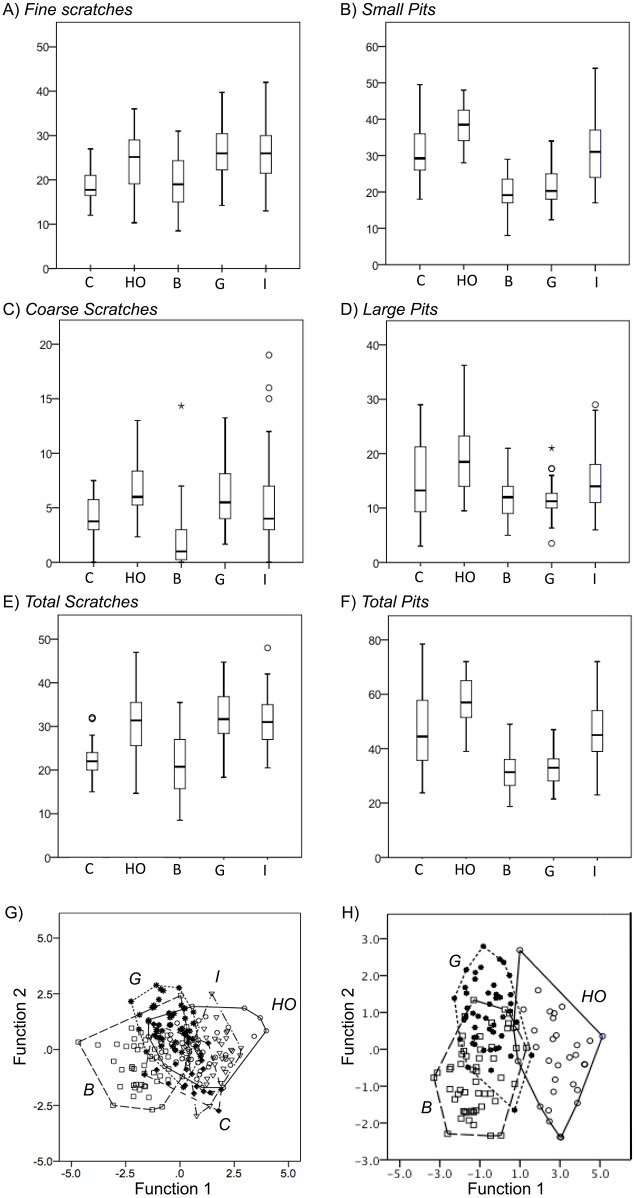
The relative frequencies of microwear variables within feeding guilds.A) Fine scratches (Sf), B) Small Pits (Ps), C) Coarse Scratches (Sc) D) Large pits (Pl), E) Total scratches, F) Total pits. Box plots show the median (center line), interquartile range (boxes), 1.5 times the interquartile range (whiskers), and outlier points. Discriminant analysis using the four independent variables (Sf, Sc, Ps, Pl) as dependents is depicted: G) all five feeding guilds included. Functions 1 and 2 are plotted and account for 71.8% and 24.6% of the variance, respectively. Wilks’ Lambda = 0.252, Chi-Square = 250.51, p<0.001. The discriminant function coefficients are Sf
0.039/0.578, Sc
0.499/0.688, Ps
0.845/−0.416, Pl
0.071/−0.166. F) Herbivores groups only (grazers, browsers, hard-object feeders). Functions 1 and 2 are plotted and account for 75.1% and 24.9% of the variance, respectively; Wilks’ Lambda = 0.194, Chi-Square = 192.80, p<0.001. The discriminant function coefficients are Sf
0.005/0.379, Sc
0.324/0.844, Ps
0.822/−0.330, Pl
0.270/−0.276. HO = Hard-Object Feeders, B = Browsers, G = Grazers, I = Insectivores, C = Carnivores. Hulls surround each dietary group.